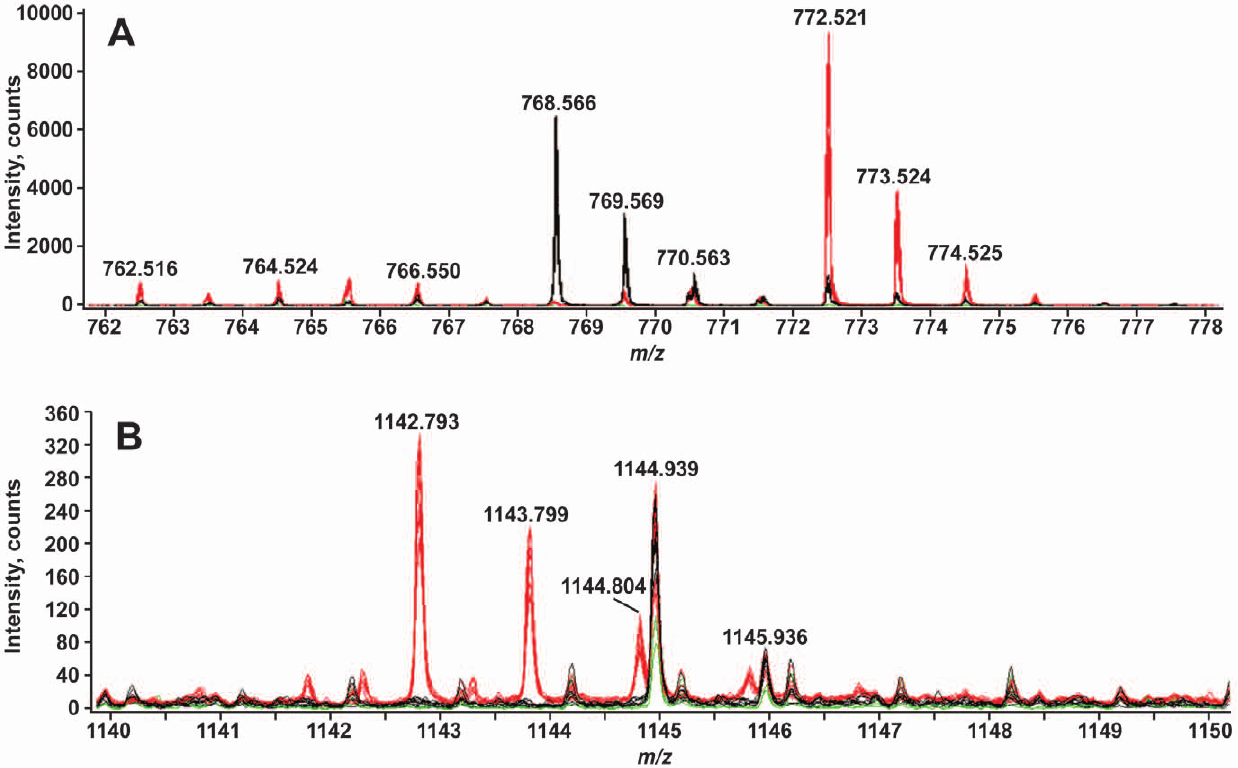
Figure 10. Lipids that differ between aposymbiotic and symbiotic lipid extracts. The figures show the overlay of the negative-ion LC-MS of 9 aposymbiotic (black), 9 symbiotic (red) and 3 FLAp1AB (green) lipid extracts. Panel A shows the lipids from m/z 710 to 805 that elute between 23.8 and 24.2 minutes. Based on MS and MS/MS we hypothesize that the lipid at m/z 772.5 is 39:2 pPE and at m/z 768.5 is 39:4 pPE. Panel B shows the lipids from m/z 1140 to 1150 that elute between 25.9 and 26.6 minutes. The exact structure of the lipid at m/z 1142.8 has not been determined.